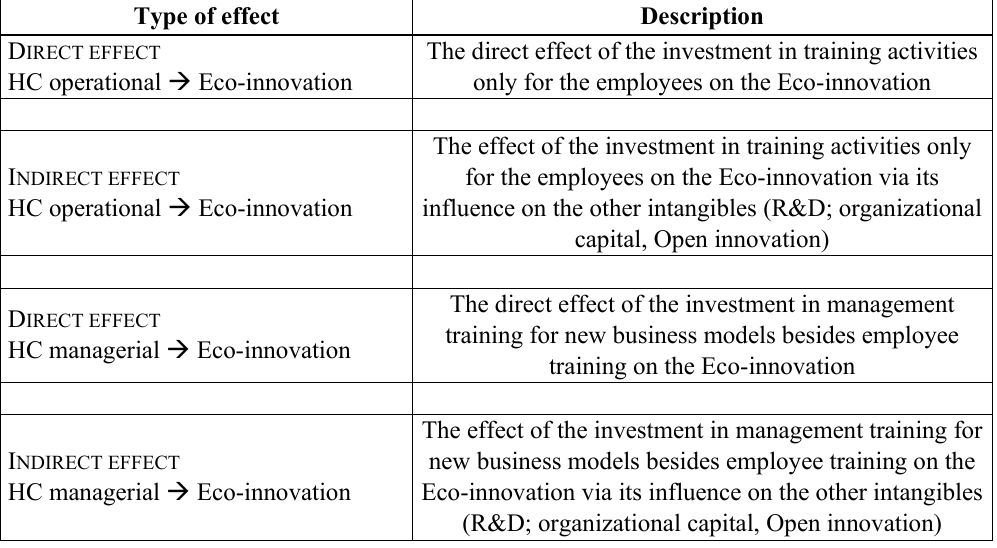
Table 1: The Effects of Human Capital on